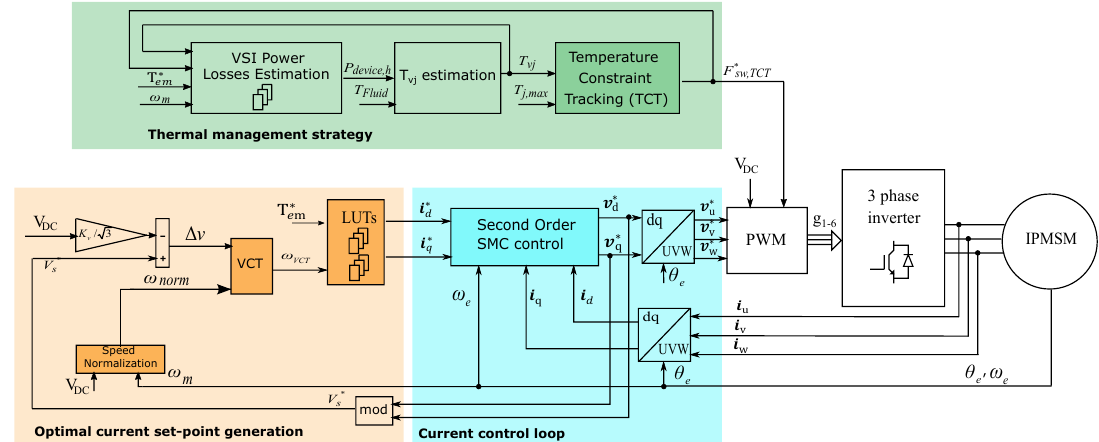
Figure 1. General diagram of the Interior Permanent Magnet Synchronous Machine (IPMSM) controller including the proposed Temperature Constraint Tracking (TCT)